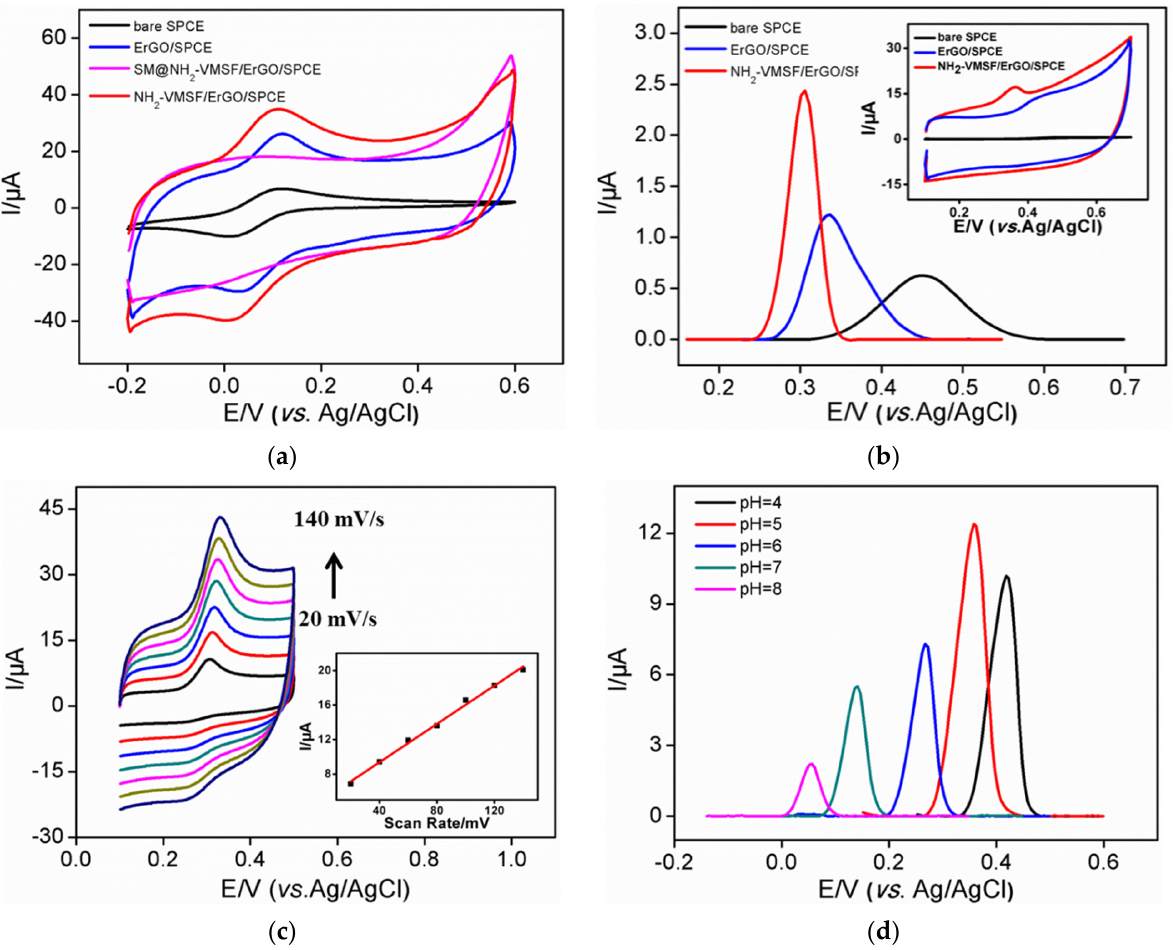
Figure 3. ( a ) Cyclic voltametric curves of Fe(CN) 63 − on different electrodes. ( b ) Differential pulse voltametric curves of UA ( b ) on different electrodes. Inset is the corresponding cyclic voltametric curve. ( c ) Cyclic voltammetry curves of UA at different scan rate. Inset is the linear regression curve between the oxidation peak current and the scan rate. The increased scan rate between two adjacent lines is 20 mV/s. ( d ) Differential pulse voltametric curves of UA at different pH.